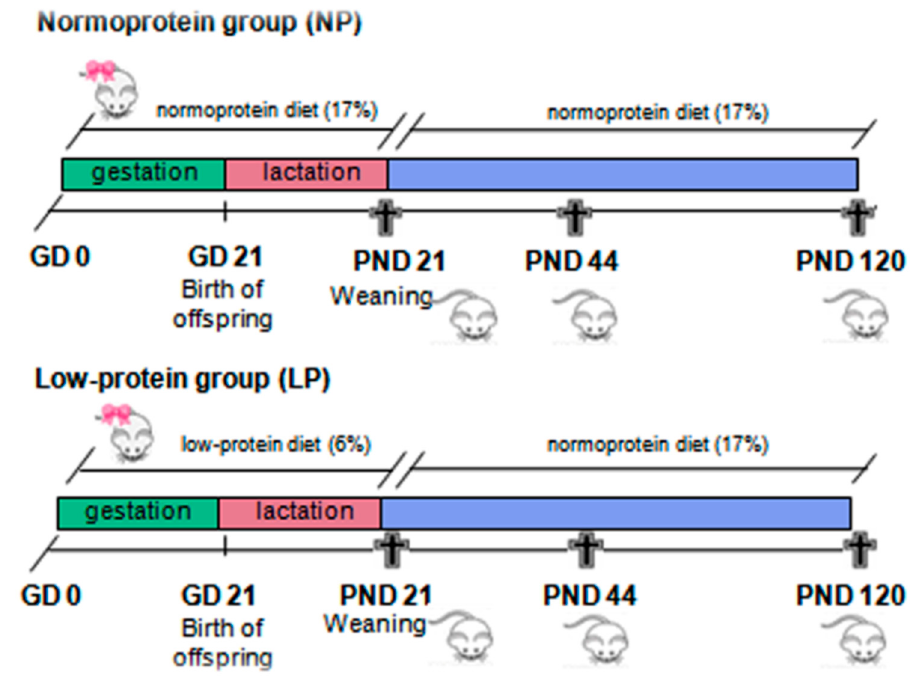
Figure 7. The experimental design. Pregnant females were fed with low ‐ protein diet (LP group) or normoprotein diet (NP group) ad libitum during gestation and lactation from GD 0 until PND